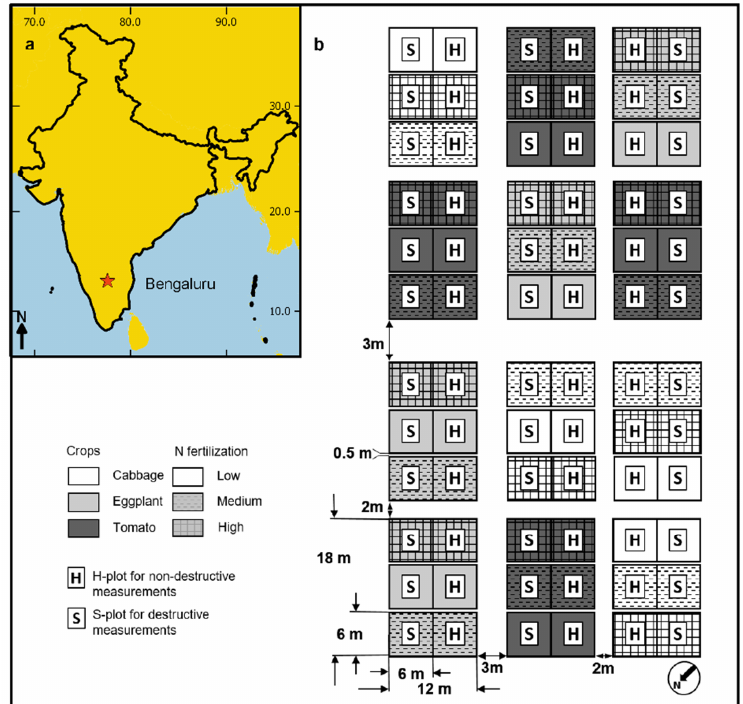
Figure 1. ( a ) Position of Bengaluru within India. ( b ) Design of the experimental layout used in this study. Different grey levels indicate the three investigated crops (white: cabbage, light grey: eggplant, and dark grey: tomato: The pattern indicates the level of nitrogen fertilization (no pattern: low, dotted: medium, and squares: high fertilization). H and S indicate the sampling plots for the destructive biomass samples (S) and the sensor data collection (H). (adjusted from [15]).